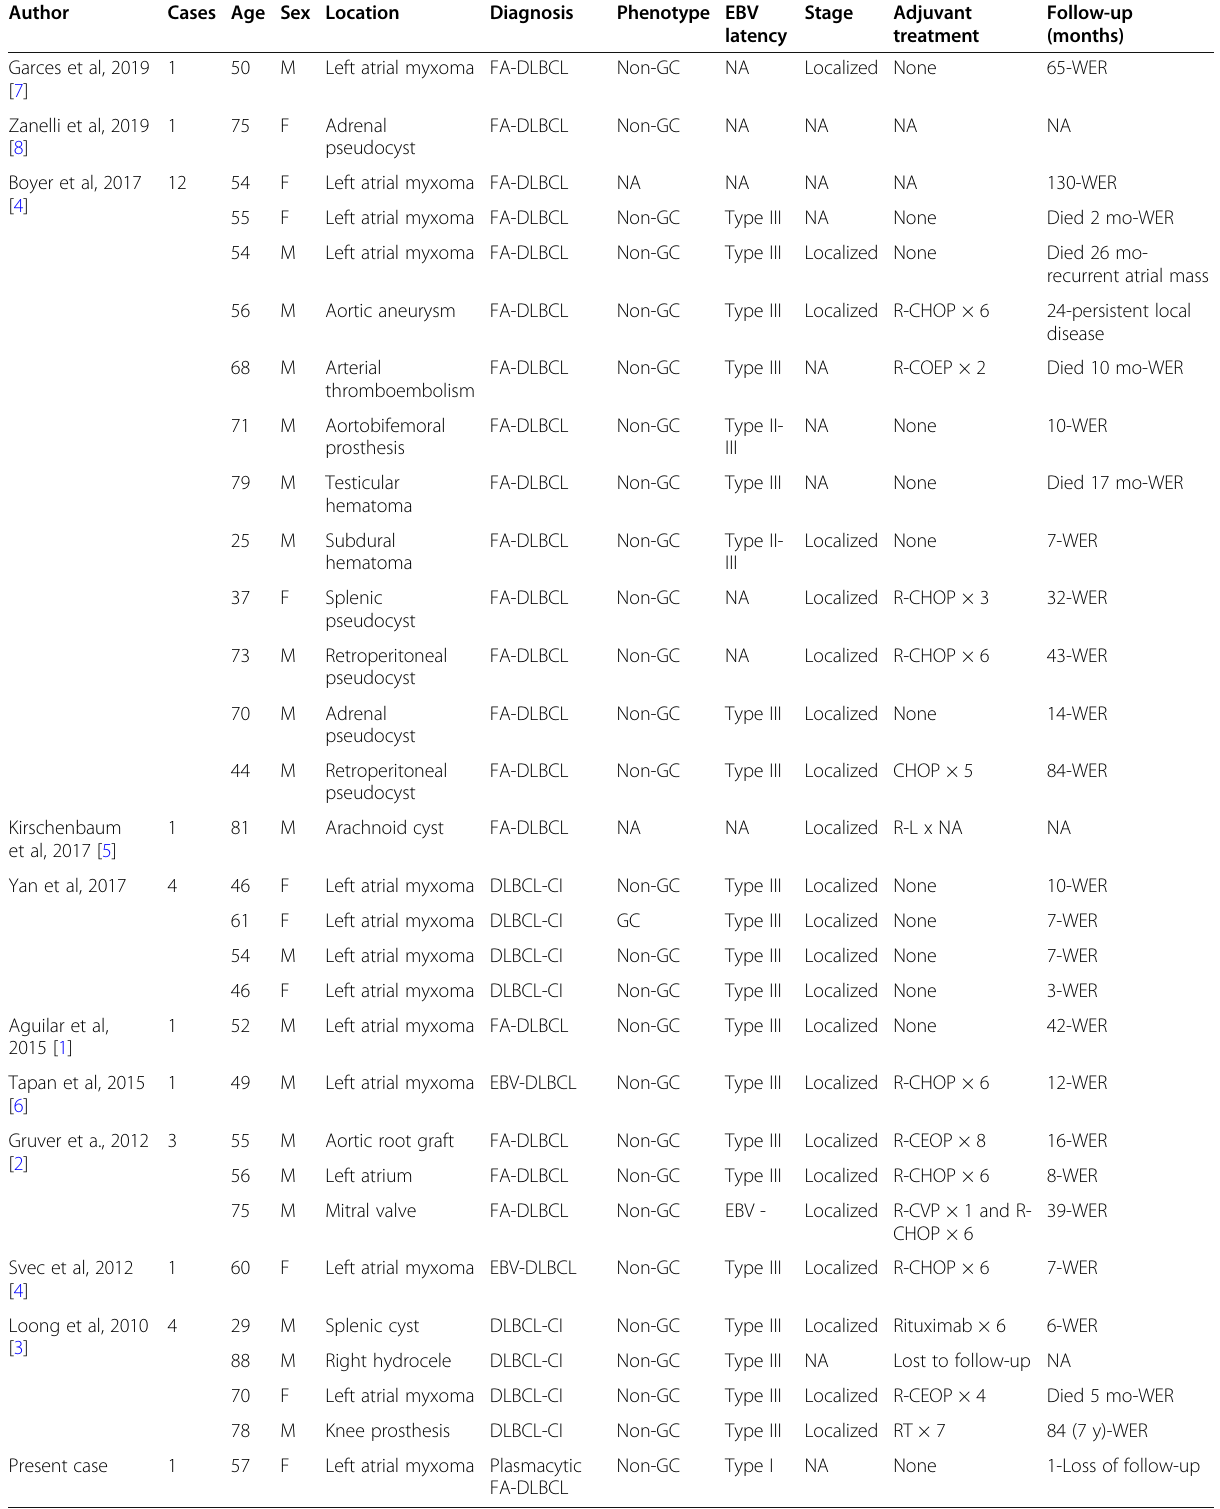
Table 1 Summary of clinicopathological features of FA-DLBCL reported cases and our case